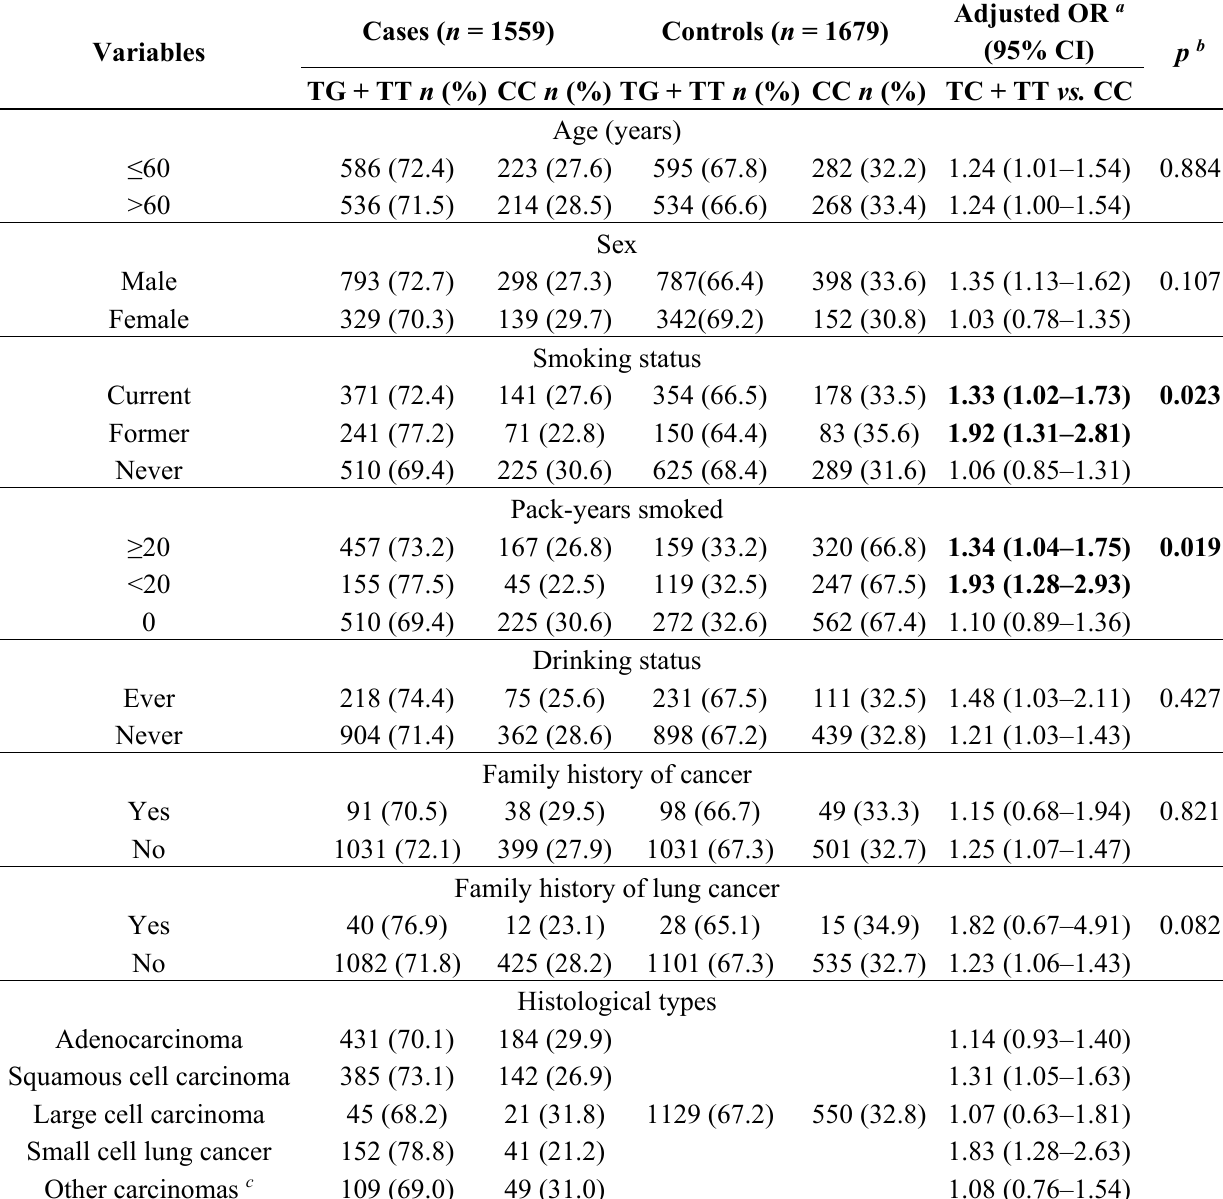
Table 2. Stratification analysis of the PXR rs3814058C>T genotypes by selected variables in lung cancer patients and